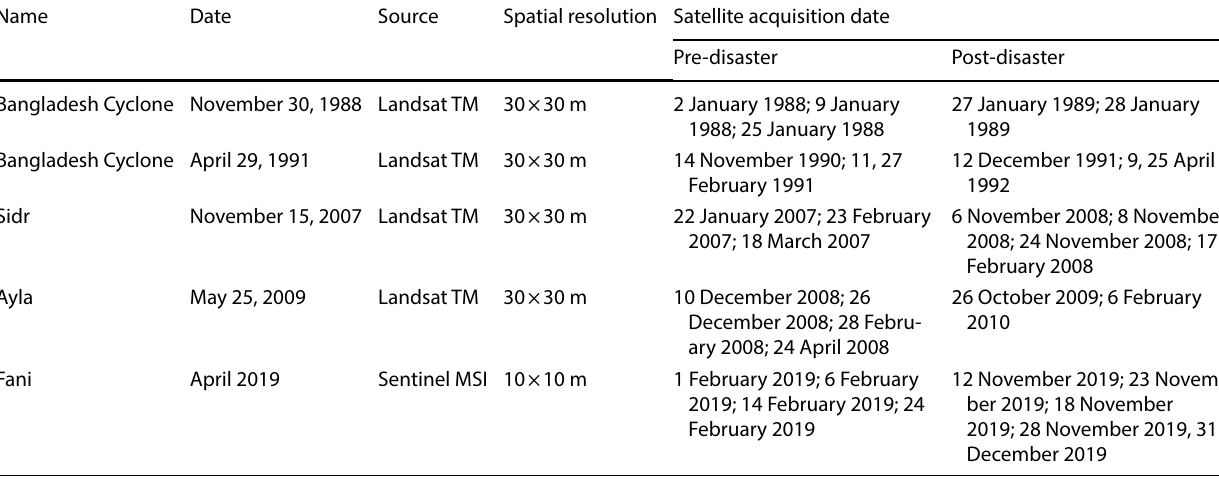
Table 1 Satellite images with acquisition dates, spatial resolution and